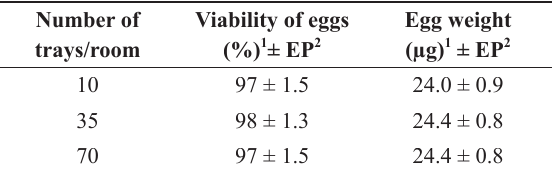
Viability and weight of eggs from females of A. kuehniella emerged in rearing trays kept in rooms with different concentrations of CO . Temperature: 25 ± 3°C, RH 60 ± 2 10%, 14h photophase, atmospheric CO 2